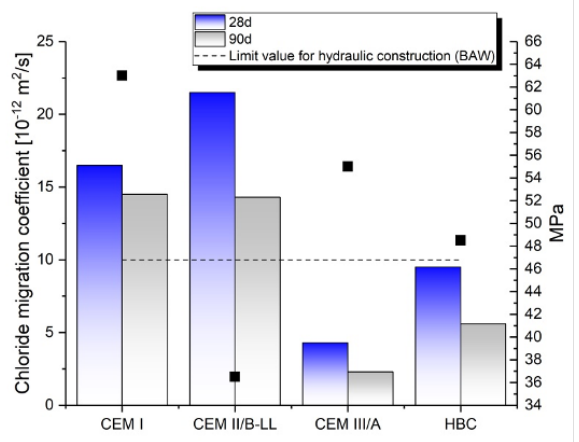
Figure 3. Chloride migration coe ffi cients of C1 con- cretes. The solid square symbols show the compres- sive strength values at 28 days of hydration of mor-